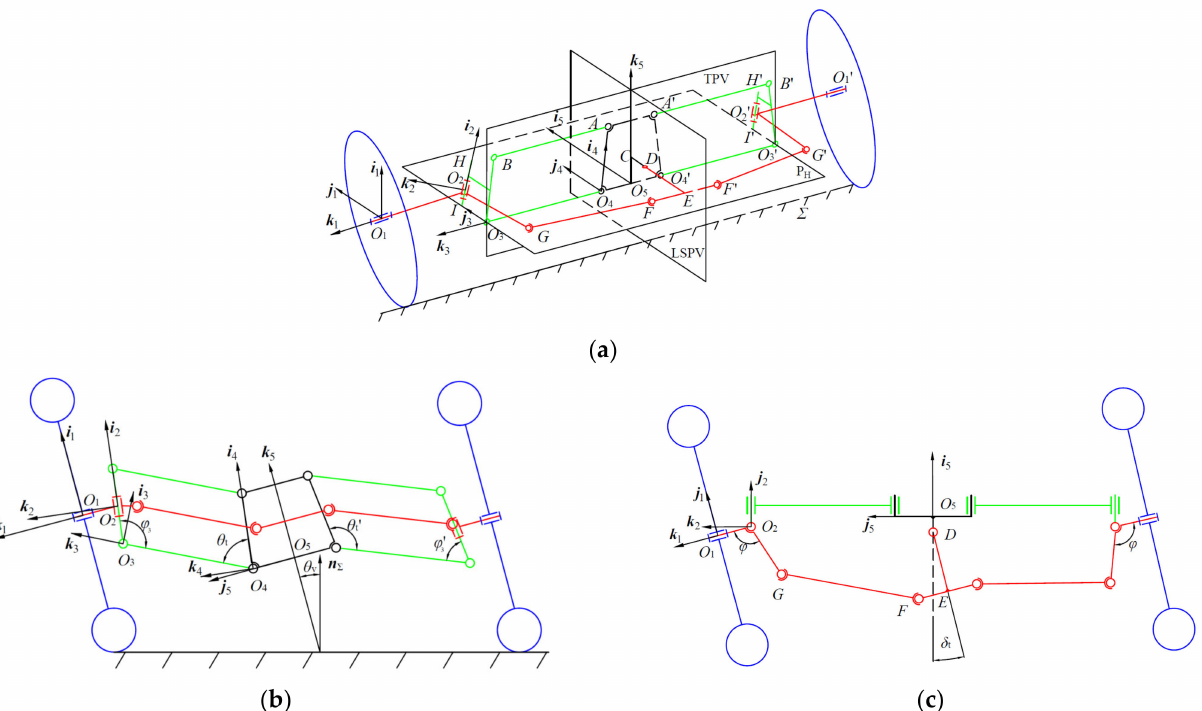
Figure 1. Schematic diagram of the parallel mechanism. ( a ) The parallel mechanism without tilting and turning; ( b ) Projection of the parallel mechanism on the TPV when the vehicle tilts to the left and turns to the left; ( c ) Projection of the spatial steering mechanism on the P H when the vehicle tilts to the left and turns to the